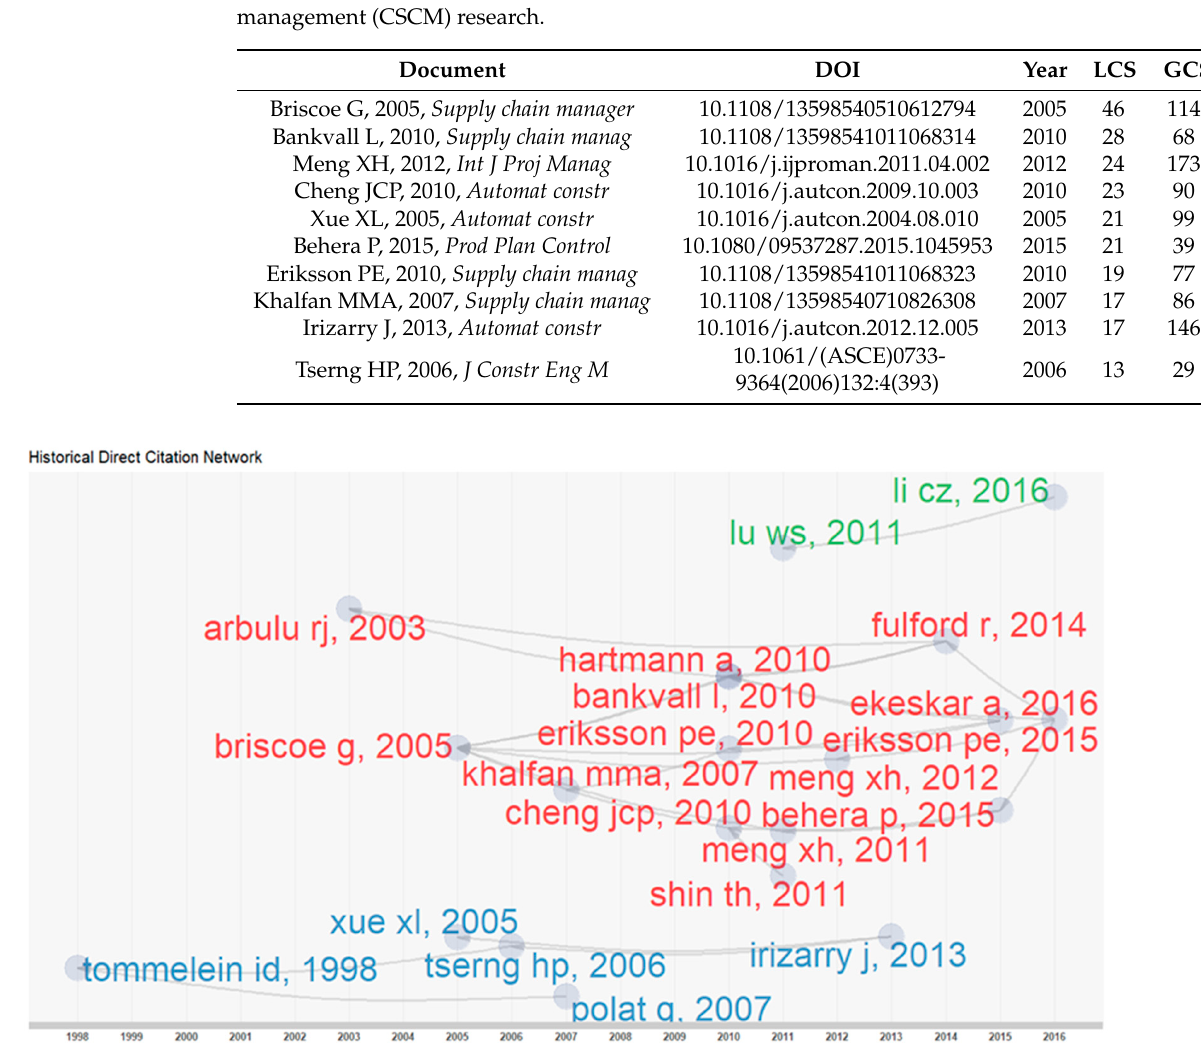
Figure 3 . Historical direct citation network of the 20 top-cited papers in the field of CSCM from 1998 to 2021.